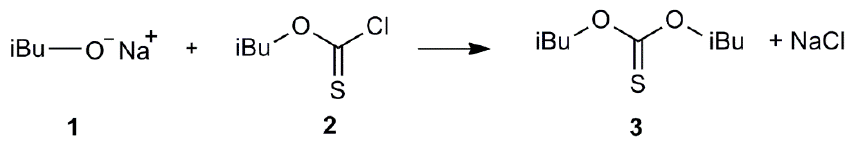
Figure 6. Reaction of alkyl alkoxides and O -isobutyl